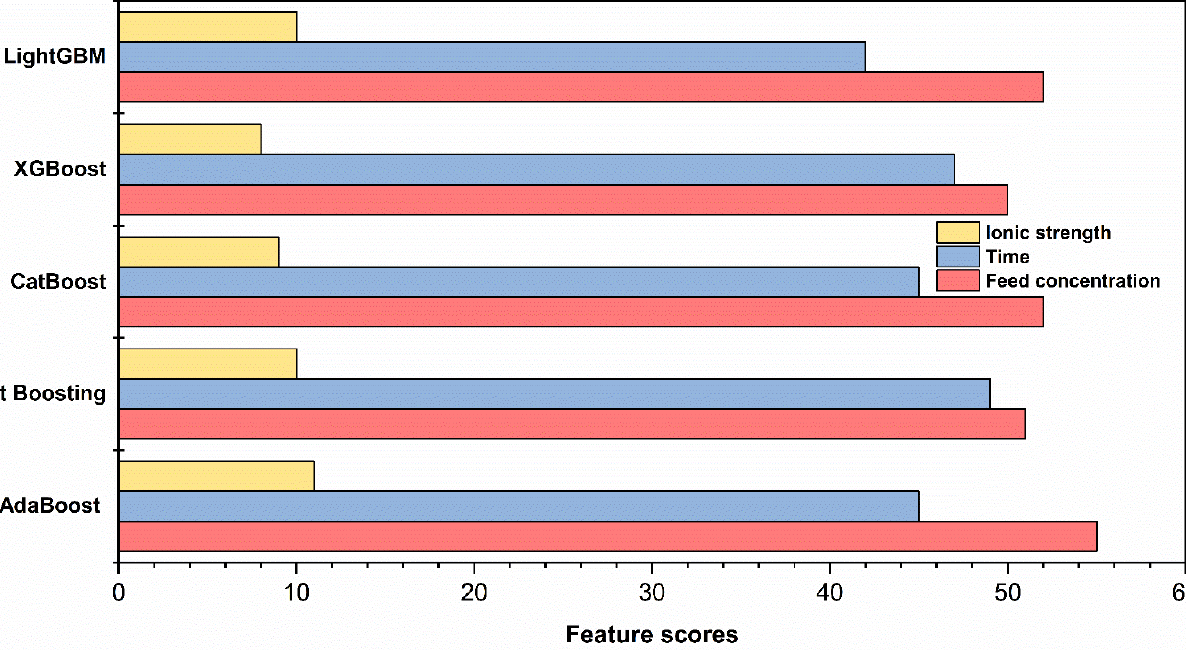
Figure 11. Feature importance